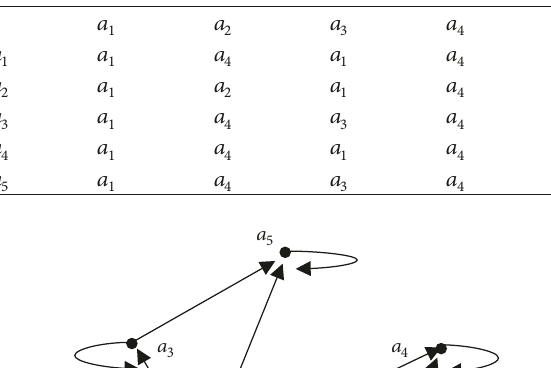
Table 1: Multiplication table of ordered semigroup 𝑆 .